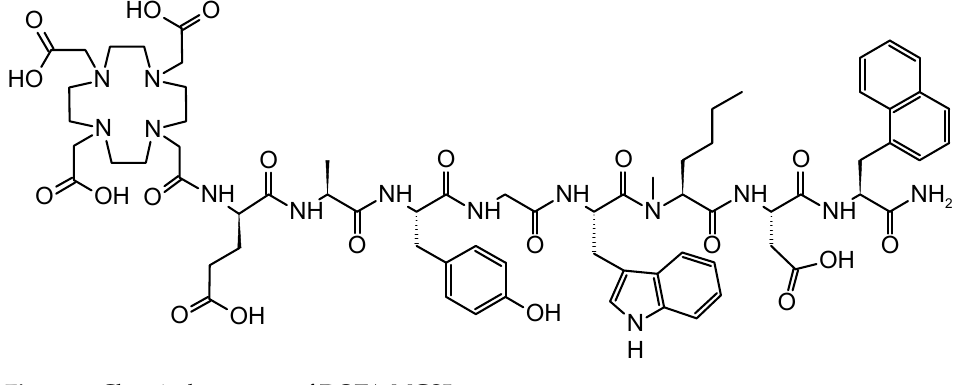
Figure 1. Chemical structure of DOTA-MGS5.